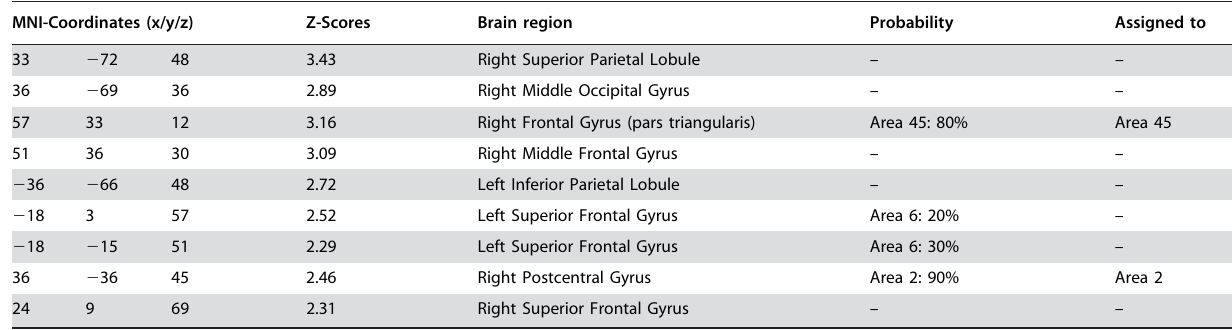
Table 5. Summary of peak locations of BOLD signal change positively correlated with individual familiarity-differences (familiarity with actively learned minus passively learned melodies, p , 0.05, K . 50, Z-scores . 2.25). .. ... .... ... ... .... ... ... .... ... ... .... ... ... .... ... ... .... ... ... .... ... ... .... ... ... .... ... ... .... ... ... .... ... ... .... ... ... .... ... ... .... ... ... . MNI-Coordinates (x/y/z)